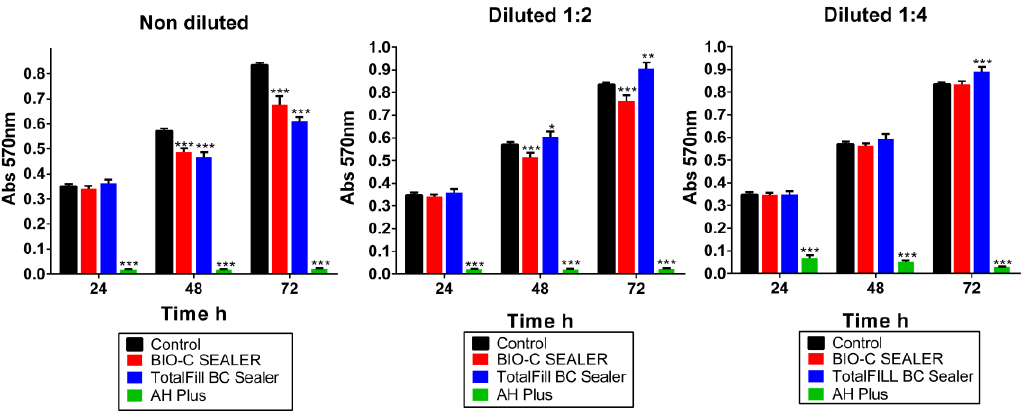
Figure 1. Human periodontal ligament stem cells viability after stimulation with Bio-C Sealer, TotalFill BC Sealer, and AH Plus, as determined by an MTT assay. (* p < 0.05; ** p < 0.01; *** p < 0.001,